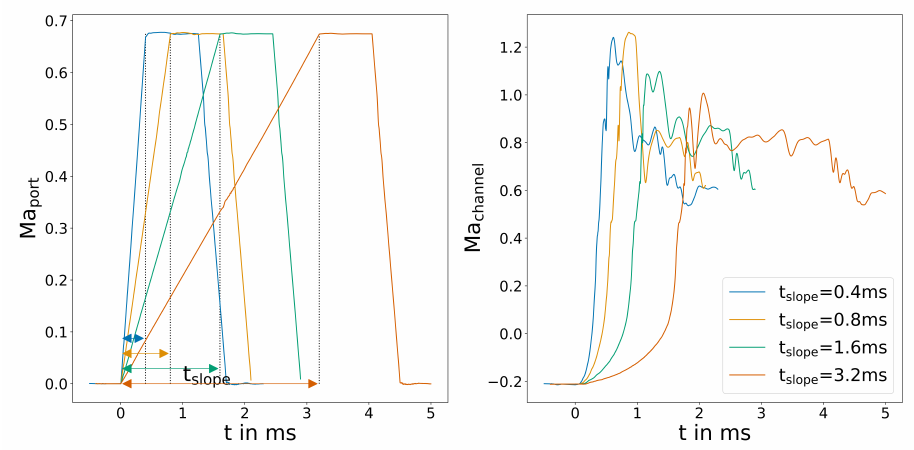
Figure 6. ( Left ) control flow velocity slopes for the parametric simulation, ( right ) averaged velocity in the output channel for variations of t slope .